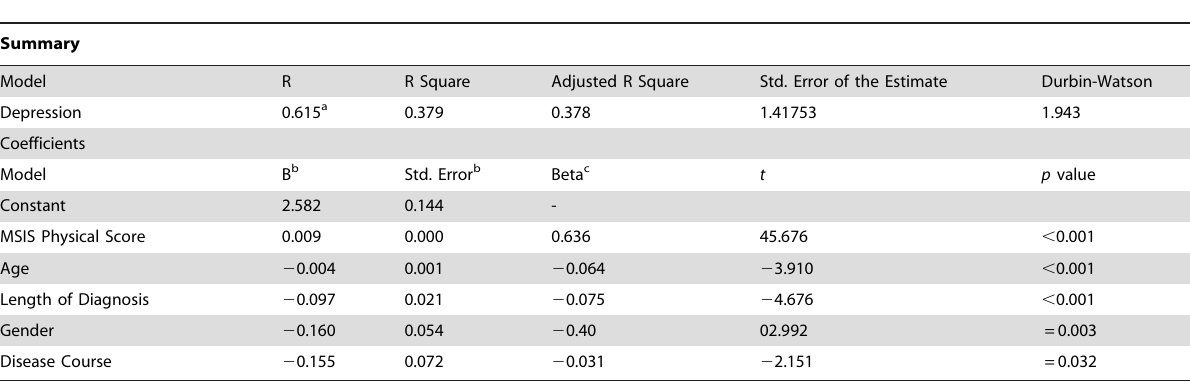
Table 3. Multiple Regression Coefficients for MSIS Physical Score for